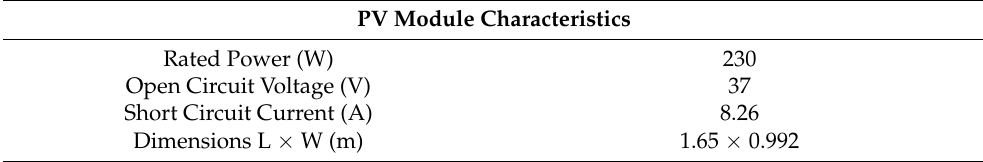
Table 6. PV-module characteristics according to TSM230PC05 from the Modelica BuildingSystems